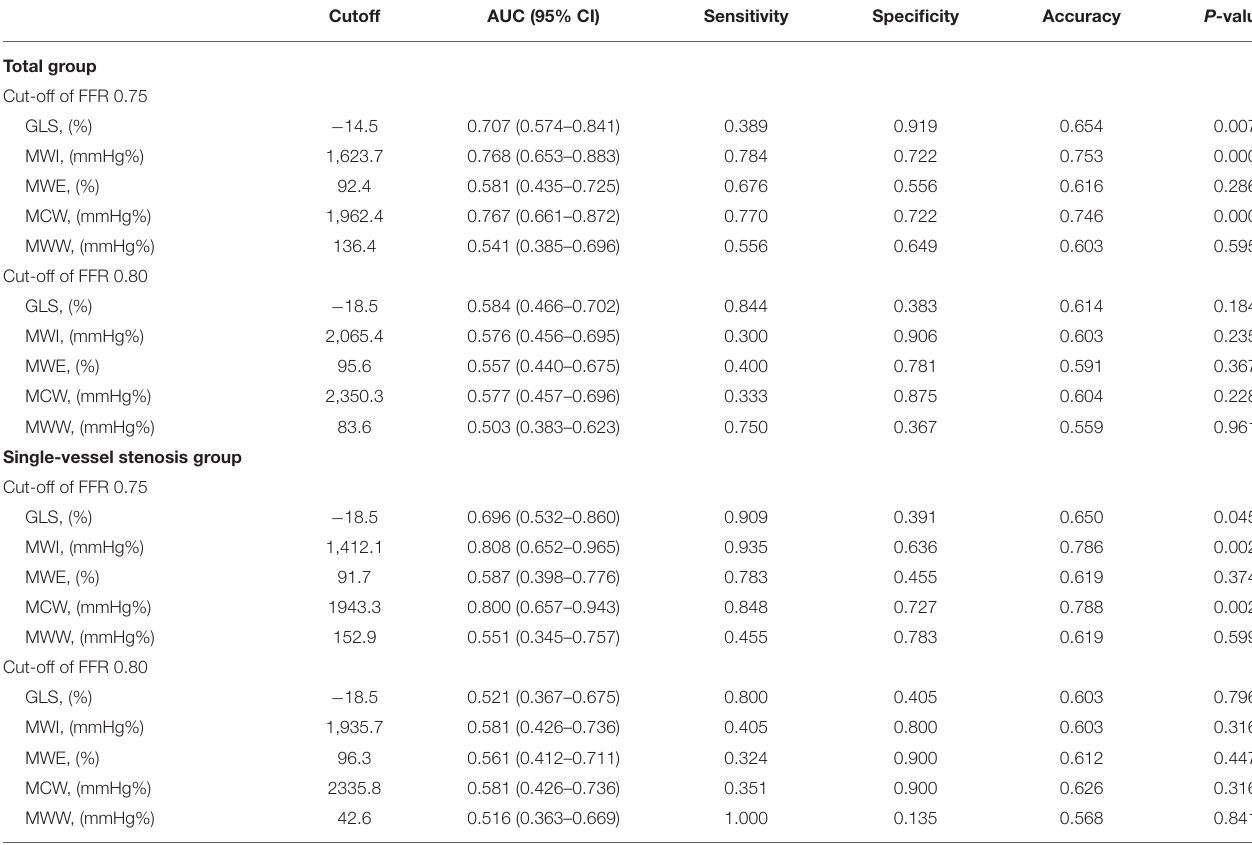
TABLE 3 | Diagnostic values of strain-related variables for detecting significant myocardial ischemia using FFR as the gold standard. Cutoff AUC (95% CI) Sensitivity Specificity Accuracy P-